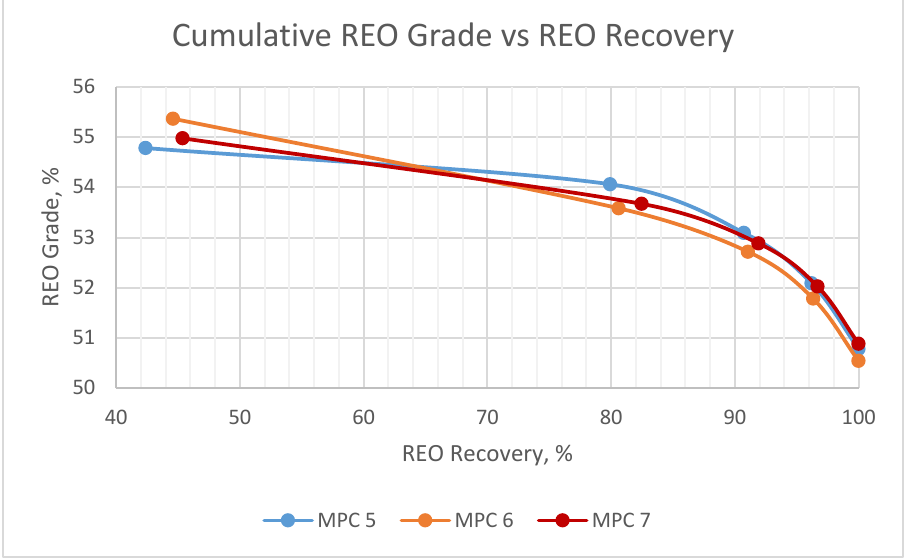
Figure 8. Cumulative REO grade/recovery for MPC UF Falcon recovery maximization testing.